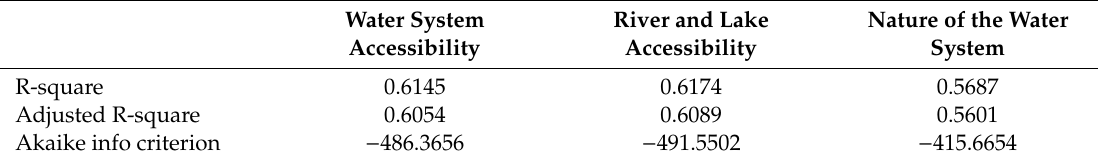
Table 8. Results of parameter estimation of Model